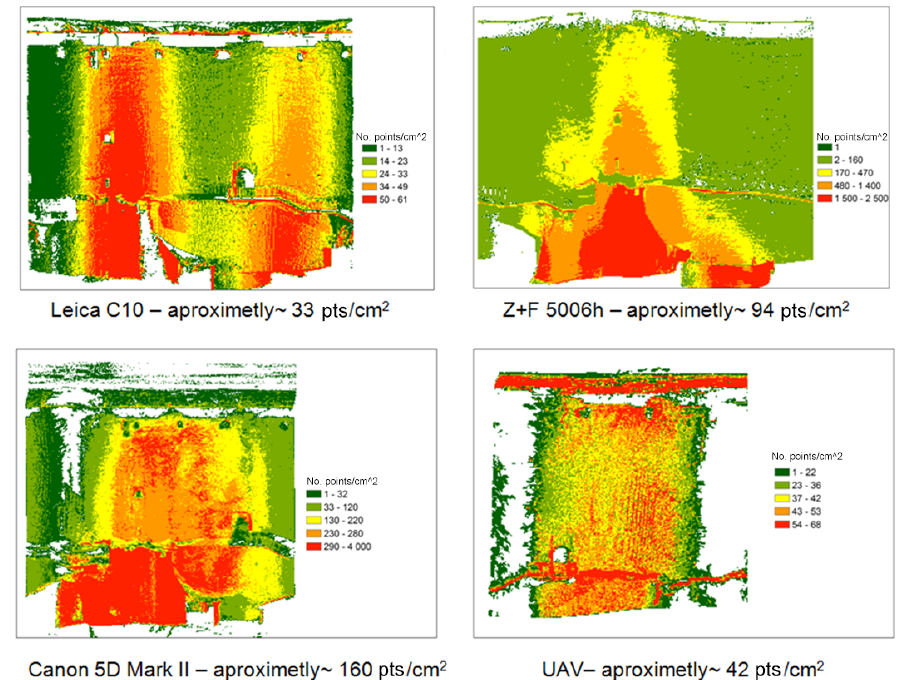
Figure 4: Distribution of the density of point clouds acquired from different